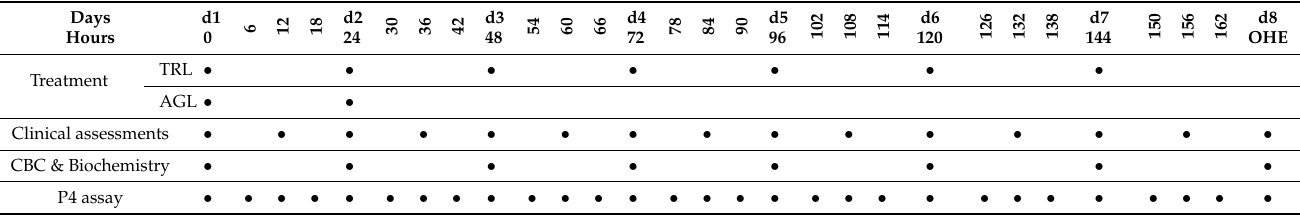
Table 1. Experimental design of the